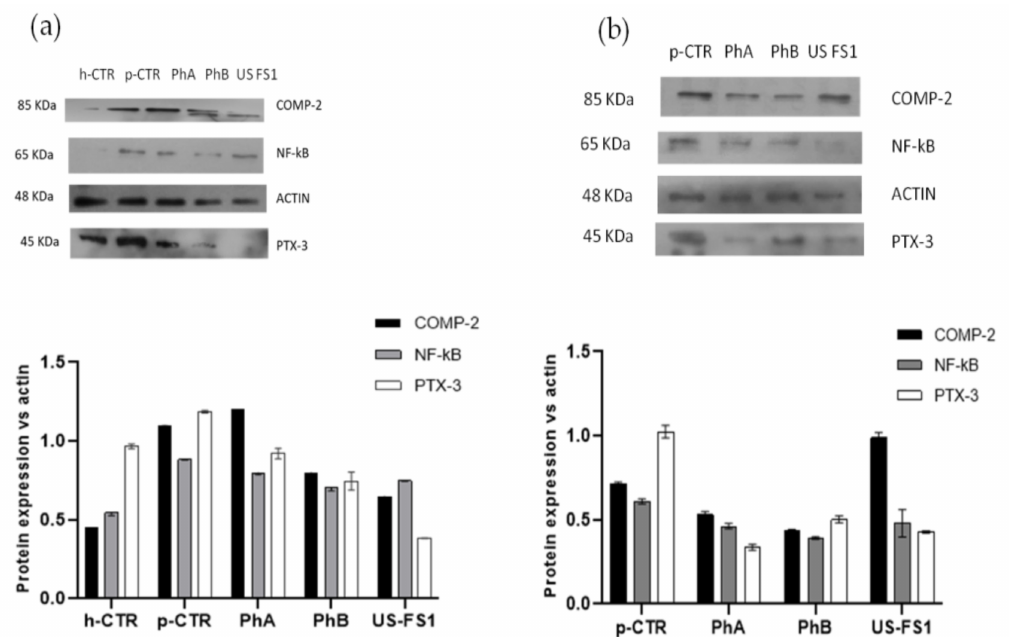
Figure 5. Western blotting analyses relative to COMP-2, NF-kB and PTX-3 on chondrocyte ( a ) and synoviocytes ( b ) treated with USA FS in comparison to PhA and PhB samples at 48 h of incubation. The expression of each protein was normalized respect to actin housekeeping protein.